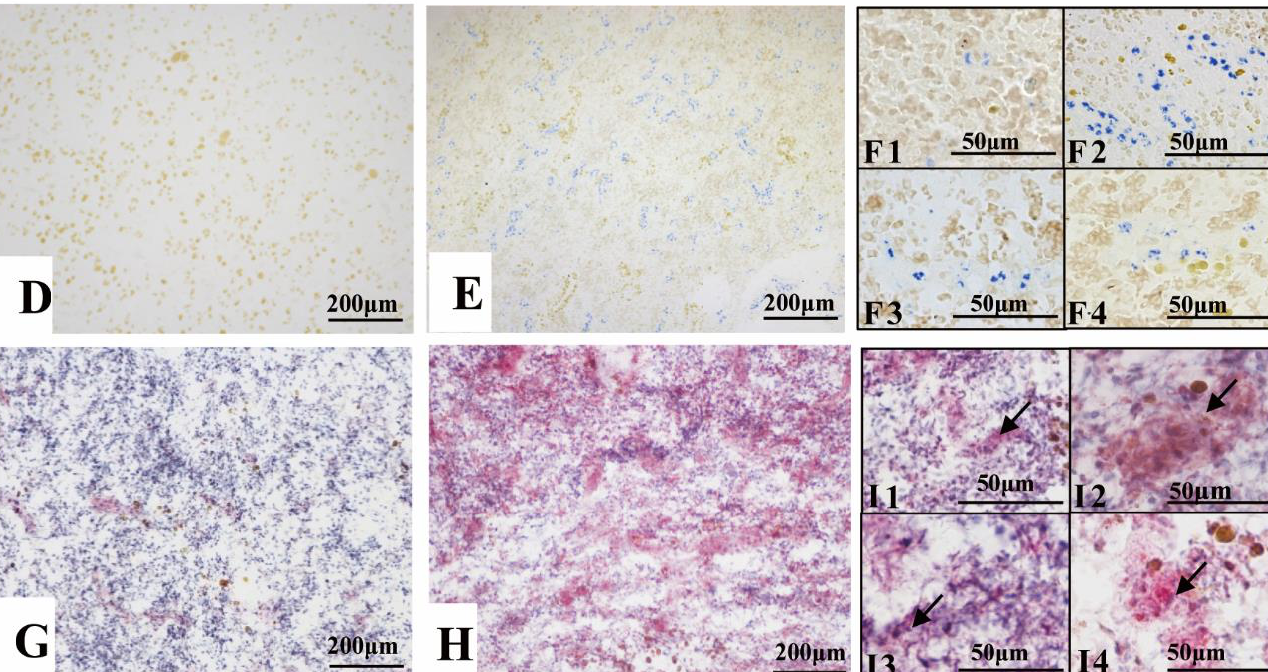
Figure 5. The dynamic monitoring of Trypan blue and ACP (Acid phosphatase) post vital staining. ( A ). 1 hpi ( i.v. ), Trypan blue scattered in the parenchyma and few of them deposited around the ellipsoids; ( B ). 3 hpi ( i.v. ), most of the Trypan blue deposited around the ellipsoids and few appeared in the parenchyma; ( C1 – C4 ) : Dynamic changes of Trypan blue deposited around the ellipsoids from 1 – 24 hpi ( i.v. ), respectively, ( C1 ):1 hpi, ( C2 ): 2 hpi, ( C3 ): 3 hpi and ( C4 ): 24 hpi; ( D ): Control spleen without any Trypan blue; ( E ). 8 hpi ( i.p. ), Trypan blue aggregated in the ellipsoids; ( F1 – F4 ): Dynamic changes of Trypan blue in the ellipsoids from 4 – 72 hpi ( i.p. ), respectively, ( F1 ): 4 hpi, ( F2 ): 8 hpi, ( F3 ): 24 hpi, ( F4 ): 72 hpi; ( G ). Normal spleen present little ACP in the endotheliocytes of EC; ( H ). 8 hpi ( i.p. ), ACP appeared in the endotheliocytes of EC and cells of the splenic cords; ( I1 – I4 ): Dynamic changes of the ACP ( → ) from 4 – 72 hpi( i.p. ), respectively, ( I1 ): 4 hpi, ( I2 ): 8 hpi, ( I3 ): 24 hpi, ( I4 ): 72 hpi; Staining method: ( A – F ), paraffin sections without staining; ( G – I ): frozen sections with Gomori staining.